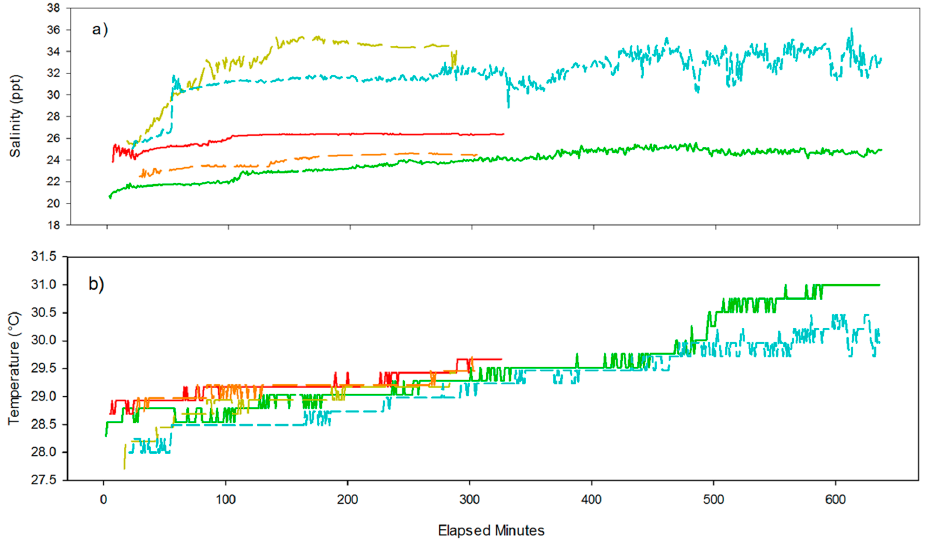
Figure 7. Salinity ( a ) and temperature ( b ) readings from drifters 10 – 14 during deployment on September 4th 2015 across the mouth of Mobile Bay, Alabama. The color scheme is the same as Figure 2. Table 2. Deployment times, distances and final salinity measurements for six drifters released on 4 September 2014 across the mouth of Mobile Bay,